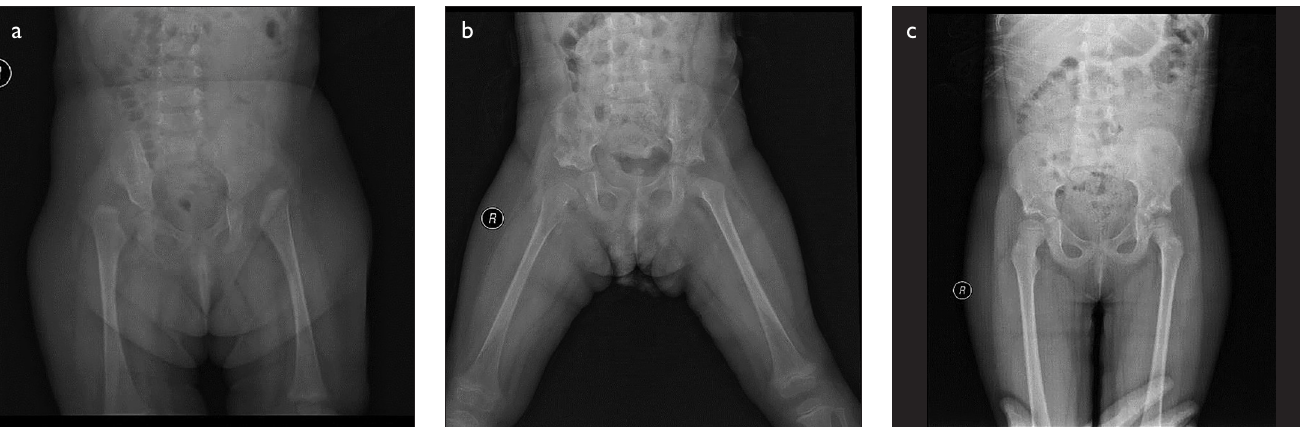
Figure 1. a-c. (a) A 9-month-old girl with right Tonnis type 3 and left Tonnis type 2 DDH. (b) The radiograph after the Ferguson surgery for the right hip and closed reduction for the left hip. (c) Postoperative month 56 of follow-up radiography.